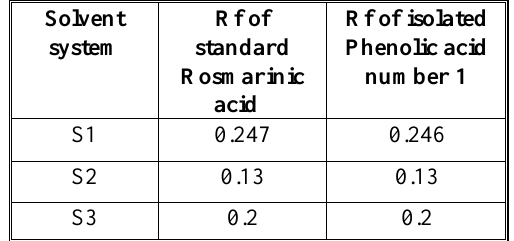
Table 3. TLC profile of isolated compound (cpd) number 1 compared with standard rosmarinic acide using the mobile phase solvents ( S1, S2, S3).